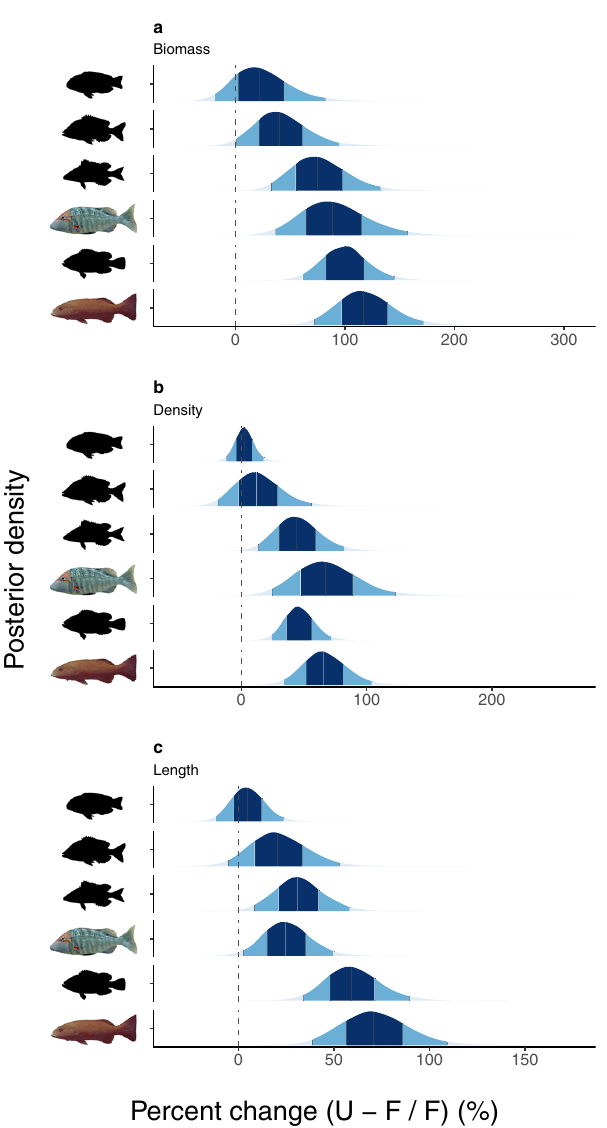
Fig. 2 Effects of no-take marine reserves on coral reef fi sh. Posterior distributions of a biomass, b density and c length, with posterior densities indicating the modelled median differences (middle line) between un fi shed (U) and fi shed (F) reefs, with associated 60% (dark blue) and 95% (lighter blue) credible intervals (see “ Methods ” ; Supplementary Method 3). A positive effect indicates higher values on un fi shed reefs. In each plot, results are presented from top to bottom for (1) Labridae (wrasses), (2) Lutjanidae (tropical snappers), (3) Lethrinidae (emperors), (4) Lethrinus miniatus and L. nebulosus (redthroat and spangled emperors), (5) Serranidae (rockcods) and (6) Plectropomus spp. and Variola spp. (coral trout). Source data are provided as a Source data fi le. Fish silhouettes for Lethrinidae, Serranidae and L. miniatus from AIMS ©, for P. leopardus from F. Kroon ©, for Lutjanidae from R package fi shualize (https://github.com/nschiett/ fi shualize, License GPL-2) and for Labridae cut and adapted to a silhouette from Fig. 2C ( Choerodon anchorago , terminal phase male) in Gomon 63